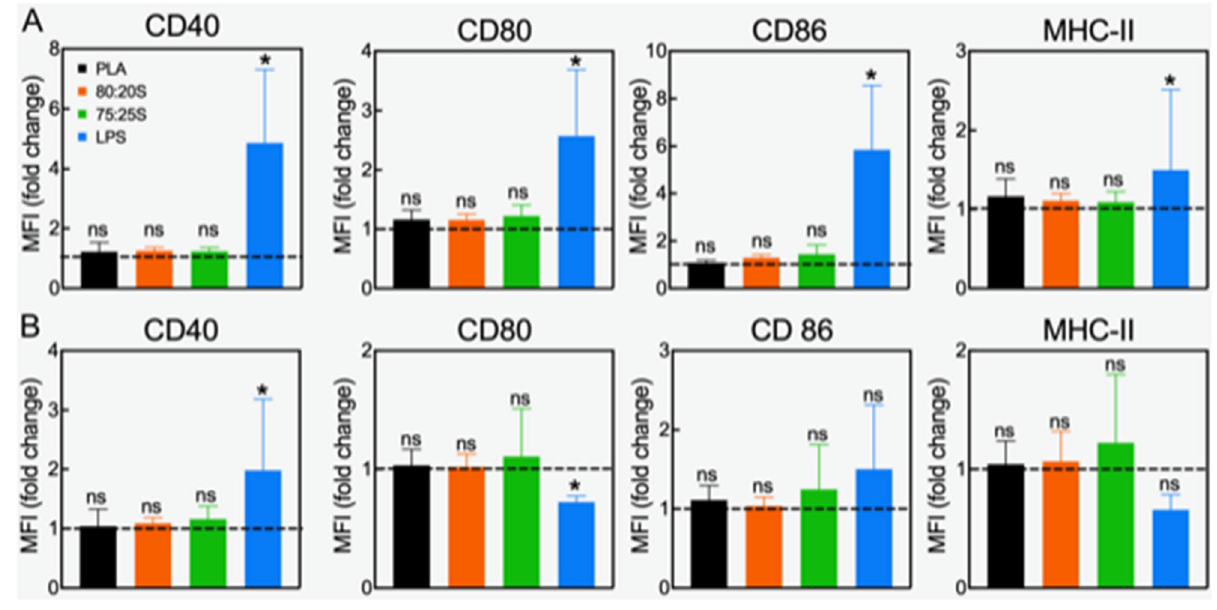
Figure 2. Surface markers expression of DC exposed to 3D-printed scaffolds for 24 ( A ) or 48 h ( B ). Results of two independent experiments using three-well replicates for each repetition are shown. Lines set to 1 represent the control (immature not activated DC). Ns no statistical difference; * p < 0.05. Please note that the statistical analysis refers to the comparison with the